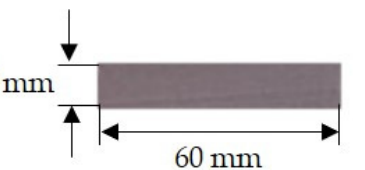
Figure 3. Presentation of gold ink-printed pattern on photopaper.